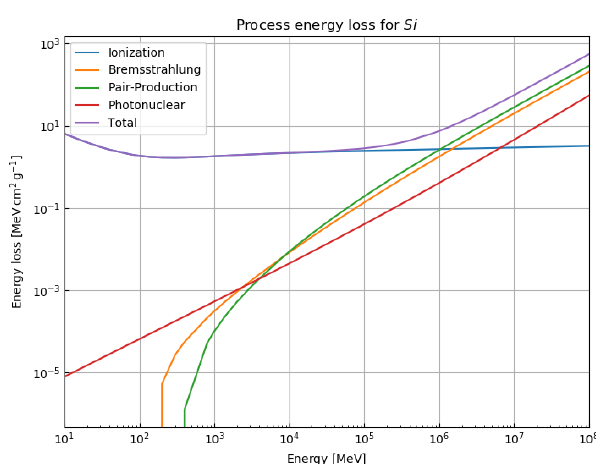
Figure E1. Log–log plot of the stopping power of the different en- ergy loss processes for silicon. At ∼ 10GeV, the radiative processes (i.e. bremsstrahlung, pair production and photonuclear interactions) reach around 1% of the total stopping power. At a few hundred GeV (at the so-called “critical energy”), the radiative processes start to become dominant over the ionisation